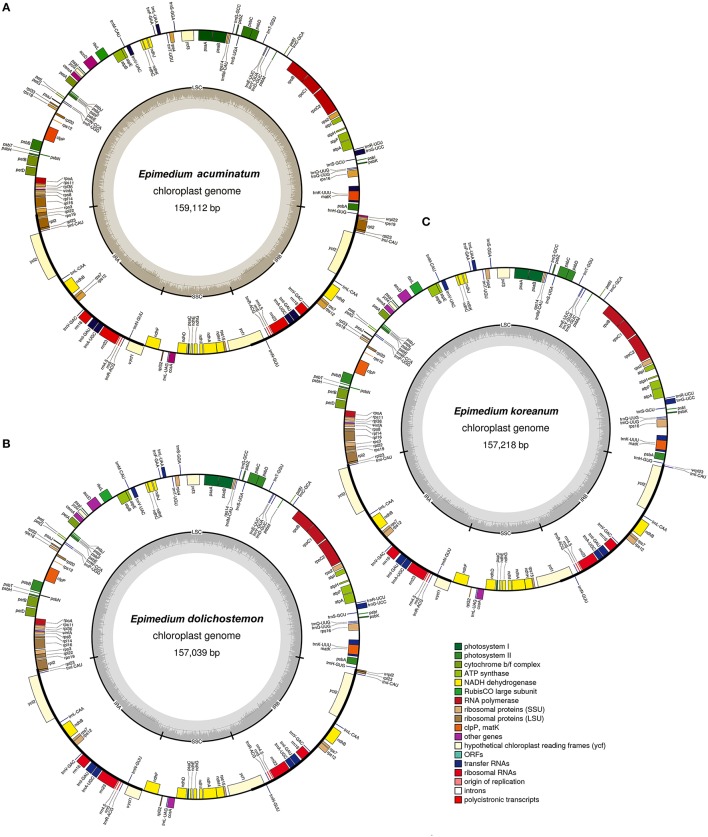
Gene maps of three Epimediumchloroplast genomes. (A)
E. acuminatum, (B). E. dolichostemon, (C). E. koreanum. Genes shown outside the outer circle are transcribed clockwise, and those inside are transcribed counterclockwise. Genes belonging to different functional groups are color coded. The dashed area in the inner circle indicates GC content of the chloroplast genomes.